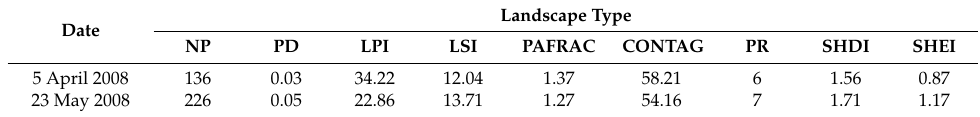
Table 2. Spatial heterogeneity change of vegetation at landscape level before and after the earthquake. CONTAG, Contagion; PR, Patch Richness; SHDI, Shannon’s Diversity Index; SHEI, Shannon’s Evenness Index.